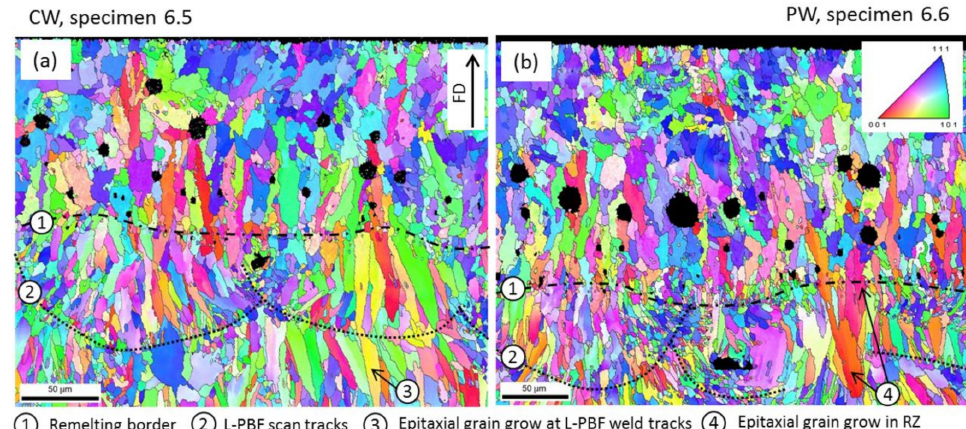
Figure 13. EBSD inverse pole figure map of the remelting zone after laser polishing without heat treatment: ( a ) CW-polished; ( b ) PW polished.